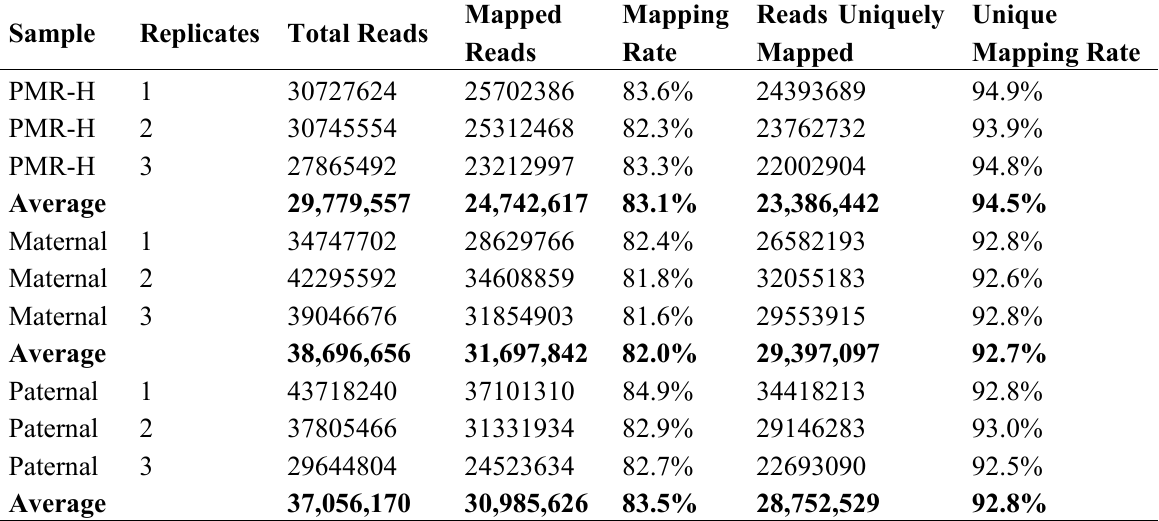
Table 1. Number of reads from high-growth allotriploid Populus progeny genotypes (PMR-H) and their diploid parents mapped to the Populus trichocarpa